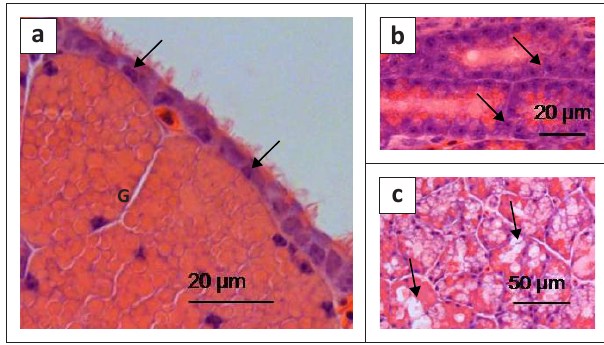
FIGURE 2: Photomicrographs of the magnum from a control bird.